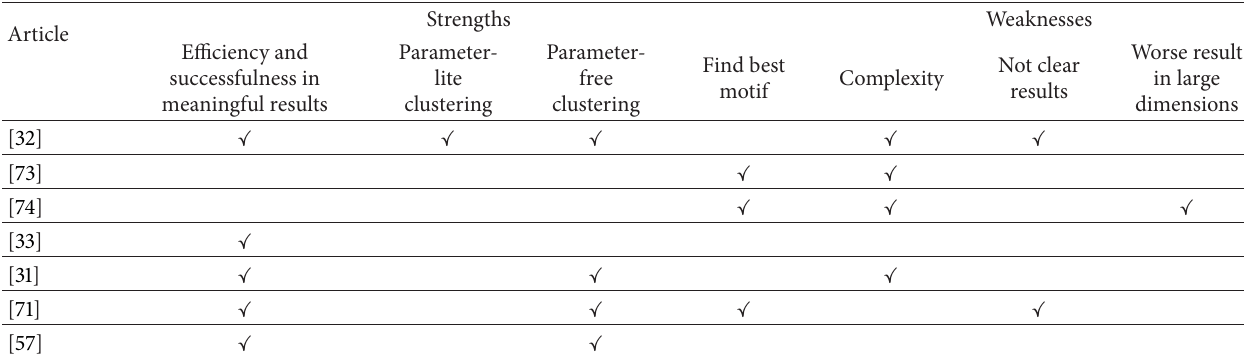
Table 6: Strengths and weaknesses of postproof period